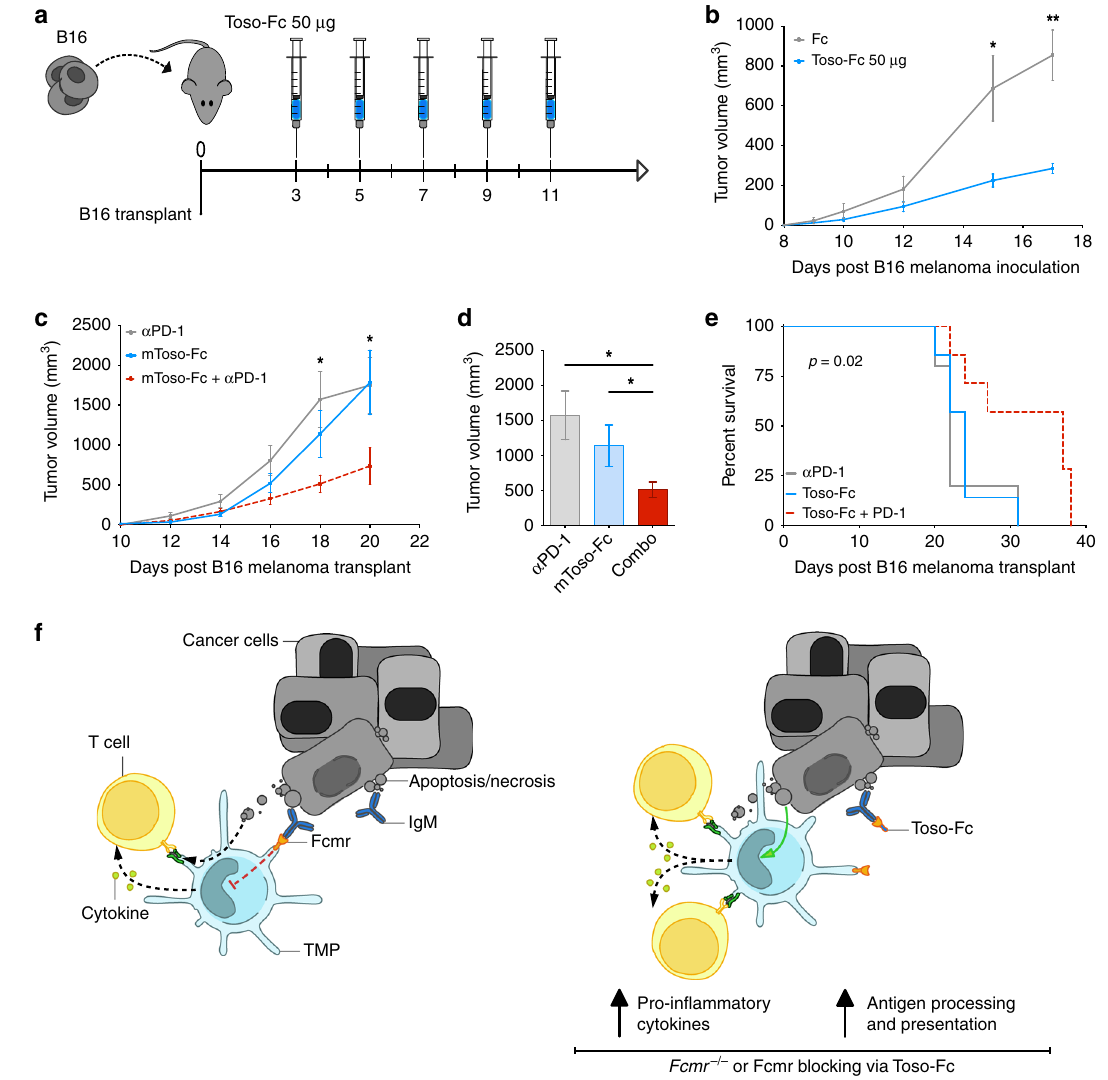
Fig. 6 Toso-Fc reduces tumorigenesis when combined with anti-PD-1. a Schematic diagram of the experiment showing the ventral – lateral transplantation of B16F0 cells superior to the inguinal LN via intradermal injection into Fcmr + / + recipient mice (left), and the associated timeline of treatment with Toso-Fc fusion protein decoy receptor starting 3 days post-transplant (right). b Time course of tumor growth in the Fcmr + / + mice receiving Toso-Fc or Fc control treatment as illustrated in ( a ) ( n = 10 mice/group). Data are representative of three separate experiments. c Time course of tumor growth in Fcmr + / + mice transplanted as in ( a ) and receiving either anti-PD-1 antibody or Toso-Fc alone, or in combination, starting at 6 days post-B16 cell transplant ( n = 8 mice/ group). d Quanti fi cation of tumor volumes in the mice in ( c ) at 18 days post-B16 cell transplant. e Survival curves for the mice in ( c ). f Schematic diagram illustrating the functional implications of Fcmr ligation in MPs within the TME. Left: Fcmr – ligand interactions normally limit antigen processing/ presentation and pro-in fl ammatory cytokine production by MPs, resulting in reduced T cell activation and decreased anti-tumor immune responses. Right: The Toso-Fc decoy receptor is hypothesized to out-compete Fcmr for binding to its ligand, preventing Fcmr – ligand interaction and thus removing the restraints on MP activation. The resulting increases in antigen processing/presentation and pro-in fl ammatory cytokine production promote T cell- mediated anti-tumor immunity. Toso-Fc is thus a potentially valuable immunotherapeutic agent. Data are represented as mean ± SEM (ANOVA t test; * p < 0.05; ** p < 0.01; *** p <